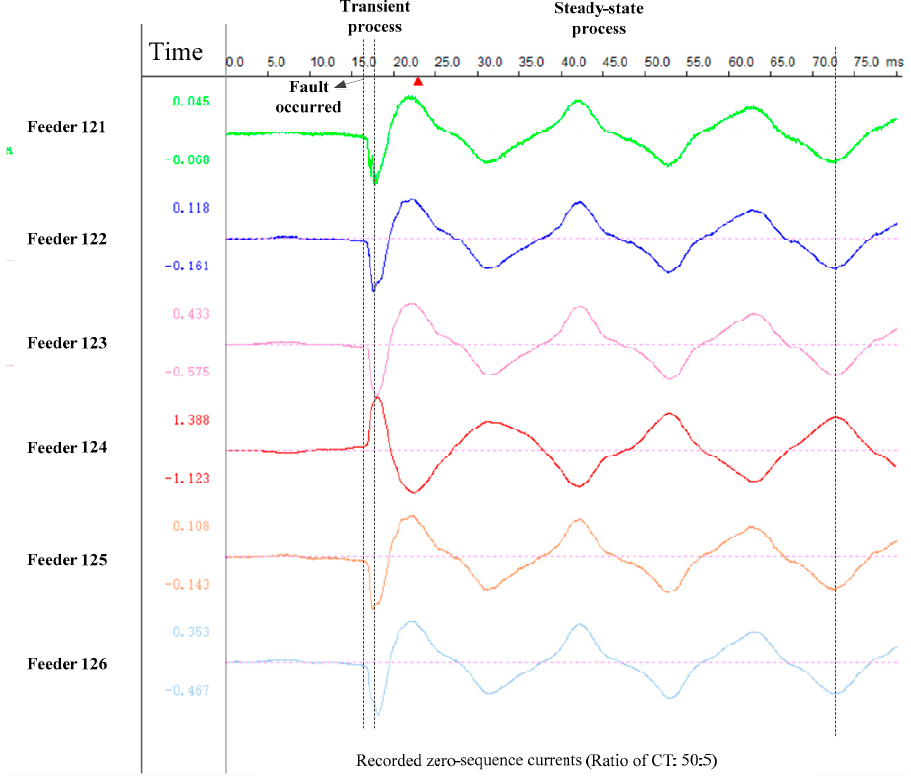
Figure 20. One typical recorded zero-sequence current waveform under a single-phase earth fault in the